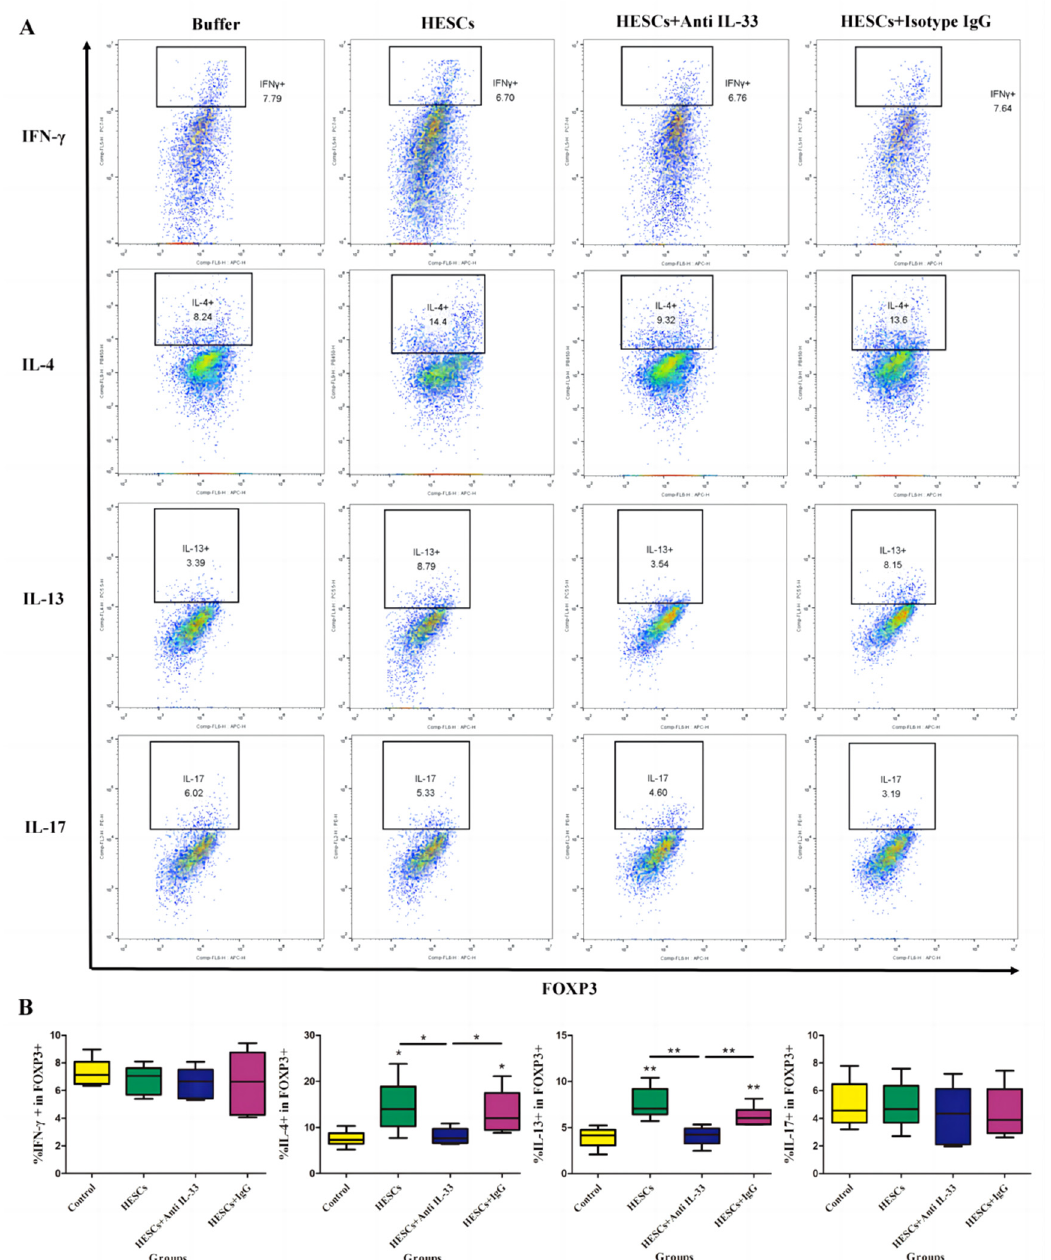
Figure 4. IL-33 stimulates the expression of Th2 cytokines in Tregs. Blood Tregs were cultured alone, co-cultured with endometriotic stromal cells or in the presence of the anti-IL-33 antibody or mock isotype IgG. After 48 h, Tregs were collected, stimulated with PMA and ionomycin, and analyzed through flow cytometry for CD4, CD25, FOXP3, IFN- γ , IL-4, IL-13, and IL-17. ( A ). Representative flow cytometry images comparing the proportion of cytokine-producing Tregs. ( B ).Cumulative data comparing the proportion of cytokine-producing Tregs. The marks on the 3 groups of co-culture indicate the comparison between the testing group and the control Tregs group. *: p < 0.05; **: p < 0.01. Data are presented in means ± SDs. Taken together, these data suggest that lesion-derived IL-33 can stimulate, via ST2, Tregs to produce Th2 cytokines, facilitating lesional progression and fibrogenesis.